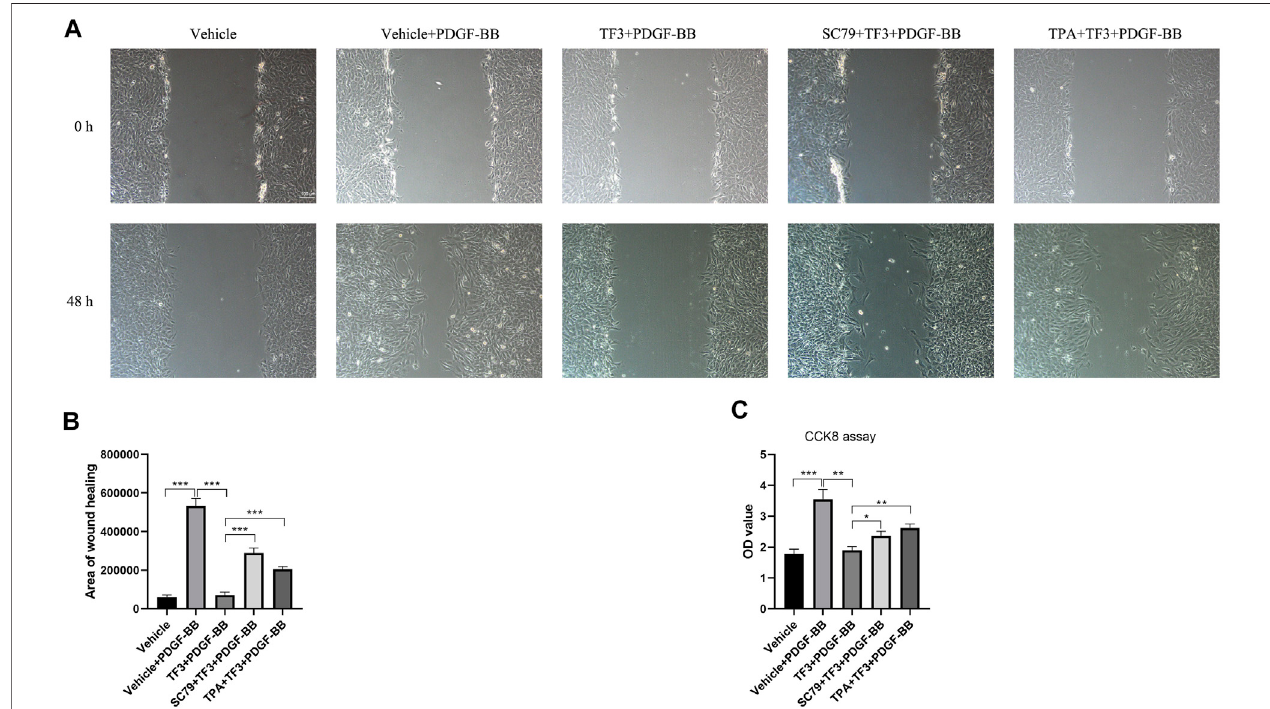
FIGURE 8 | Activation of AKT and ERK1/2 abrogate the effects of thea fl avin-3,3 ′ -digallate (TF3) on rat aortic smooth cells (RASMCs) under PDGF-BB stimulation. Serum-starved RASMCs werepretreated with20- μ MTF3, 5ug/mlSC79,and 150nMTPAfor1hand thenstimulatedwith20ng/mlPDGF-BB for48h. (A) Thewound healing migration assay was performed as indicated. Scale bar, 100 μ m (B) The statistical data of the wound healing assay is shown. (C) The CCK-8 assay was performed as indicated. Each experiment was performed in triplicate. * p < 0.05, ** p < 0.01, *** p < 0.001.